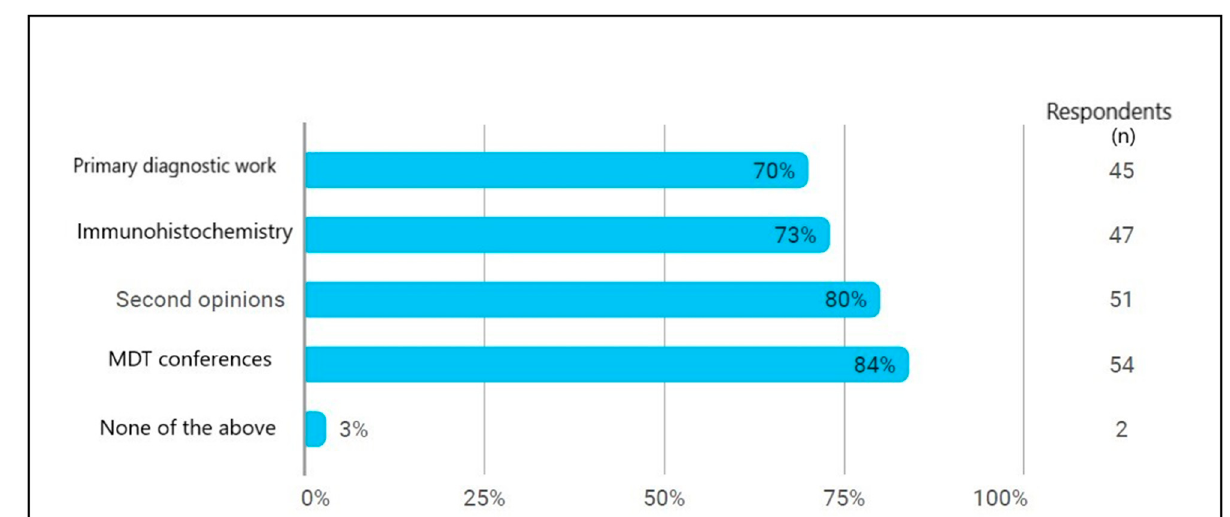
Figure 2. The pathologists’ responses to the question: “How likely is it that you personally would use digital pathology for the following clinical uses?” It was possible for each respondent to answer yes to several of the options. In all, 64 pathologists have answered the question.